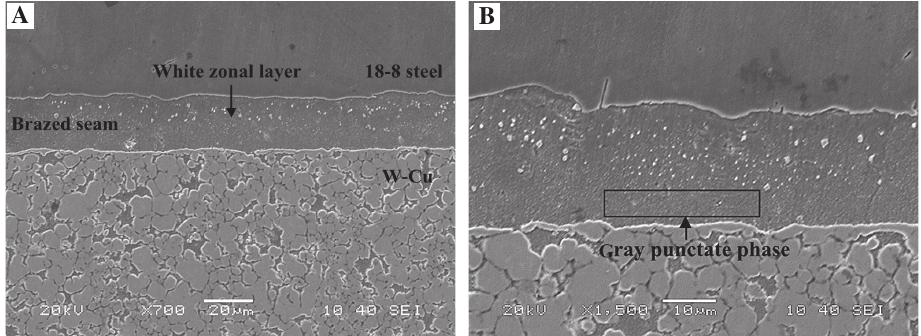
Figure 2 Microstructure of the brazing joint of W-Cu and 18-8 steel.